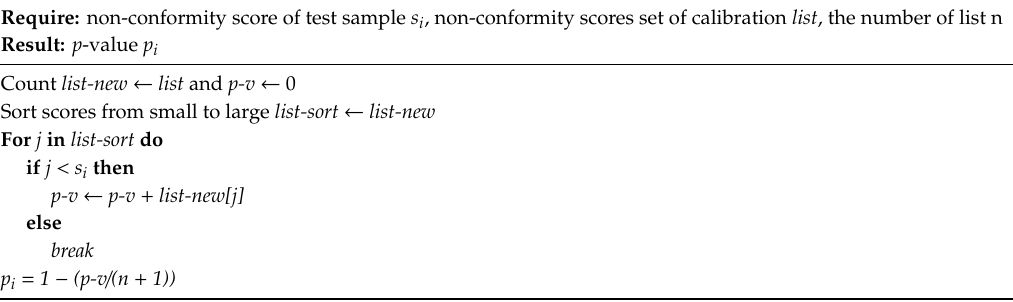
Algorithm 1. The p -value calculation time reduction